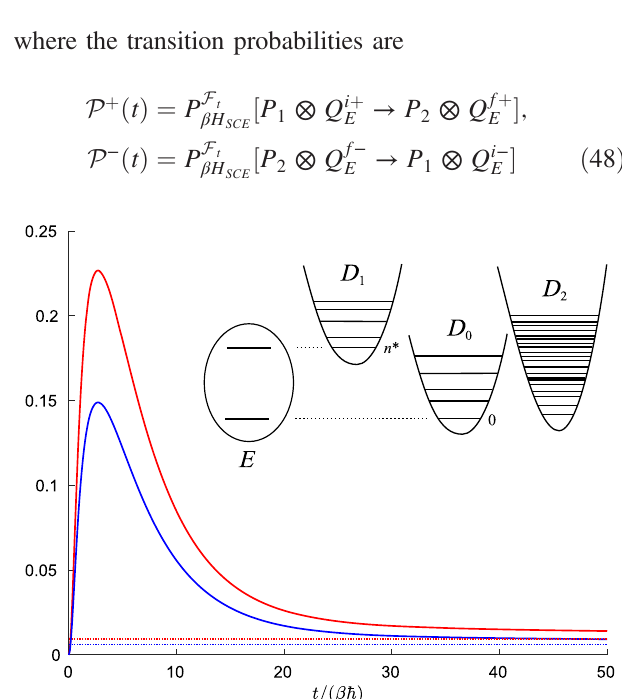
FIG. 8. Free-energy difference. The goal is to determine the free-energy difference between two basins D 0 and D 1 of states, embedded in a larger collection of configurations D 2 . Within each such collection, there is a fast thermalization process, while there is a slow global thermalization. An external energy reservoir E , in the form of a single two-level system, is in resonance with the transition between the global ground state j 0 i in basin D 0 and the local ground state j n (cid:3) i in basin D 1 . The energy reservoir acts as the counterpart to the external control in the classical EFRs. The transition probability P þ (red solid curve) of the forward process and the transition probability P − (blue solid curve) of the reverse process, as defined by Eq. (48), are plotted as functions of time, here expressed in a unit-free manner via t= ð β ℏ Þ . The ˆ 1 forward process is defined by Q i þ . The ¼ j 1 ih 1 j and Q f þ ¼ E E E transition probabilities P þ and P − can be estimated by repeated experiments, and they determine, via Eq. (47), the quotient Z 1 =Z 0 of the partition functions Z 0 and Z 1 of D 0 and D 1 , respectively, and thus also the desired free-energy difference. The dotted lines correspond to the transition probabilities in the limit of infinite evolution times, where the system has reached the fixpoint of the master